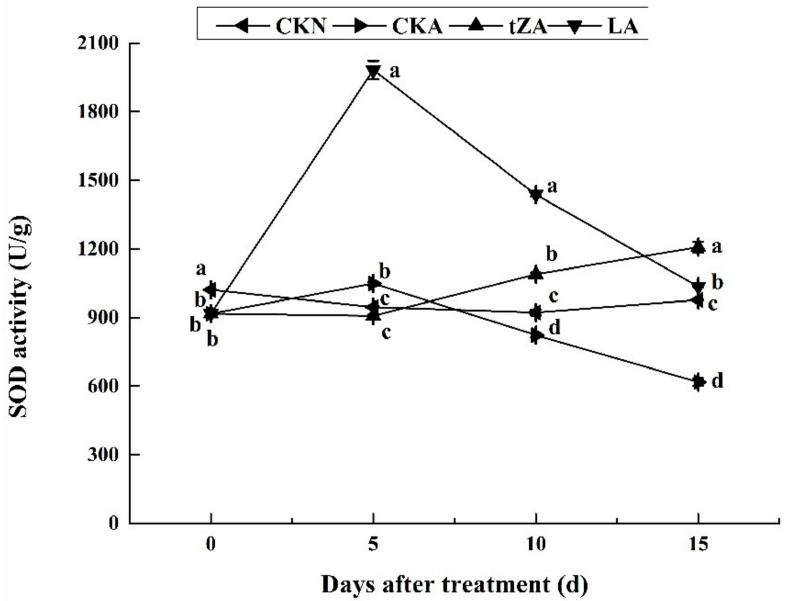
Figure 7. The changes of SOD activity in CKN, CKA, tZA and LA groups after treatment. Different lower-case letters among different treatment groups indicate significant differences based on one-way analysis of variance in SPSS 21.0 followed by the Duncan’s test ( p < 0.05). As shown in Figure 8, the expression of SOD related genes (F01_i0_LQ_F01 | c1183/ showing an increase in both the CKA and LA groups, and a trend of increase in the tZA group. At 15 days after treatment, the relative expression levels of these genes in the tZA group were close to those in normal seeds (only 0.2-fold decrease on average), while those in the CKA and LA groups were almost 2.8-fold lower than those in the normal seeds.